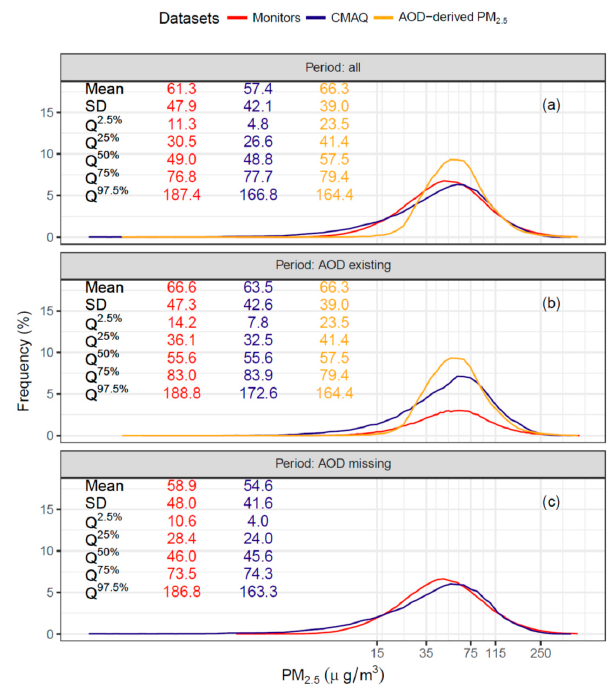
Figure 3. ( a ) Distributions of in situ observations, CMAQ simulations (0.1° × 0.1°) and AOD-derived estimates of PM 2.5 at the same spatiotemporal coordinates of monitoring data; ( b ) distributions of the subsets, conditioned that AOD data are existing; and ( c ) distributions of the subsets, conditioned that AOD data are missing. Q X% denotes the Xth percentile of a distribution.